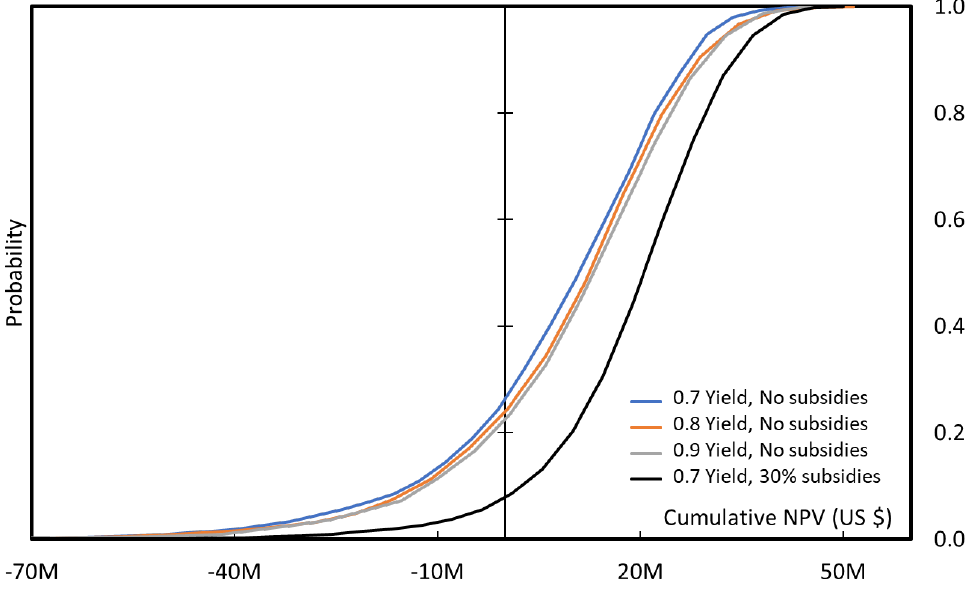
Figure 19. Probability of cumulated NPV over 10 years of production, for a 10,000 tons/year plant with and without 30% subsidies.